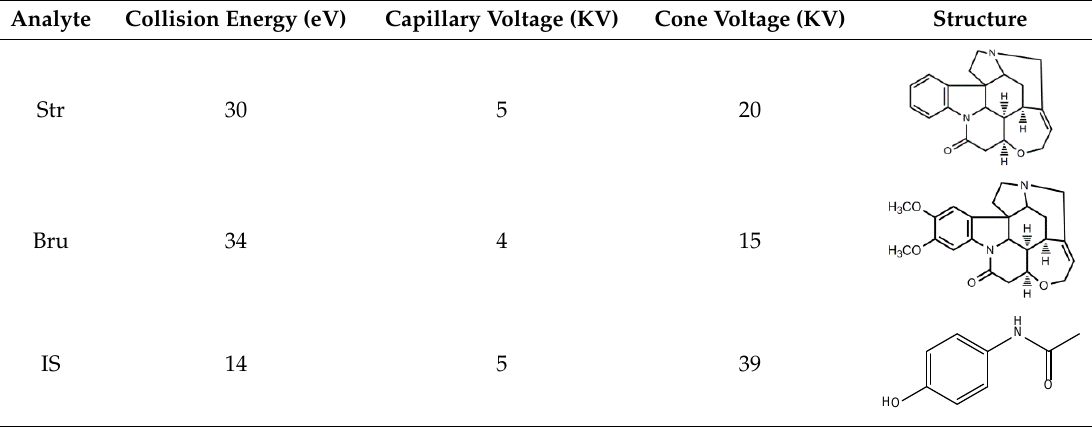
Table 1. List of multiple reaction monitoring parameters for each analyte and internal standard (IS). Analyte Collision Energy (eV)